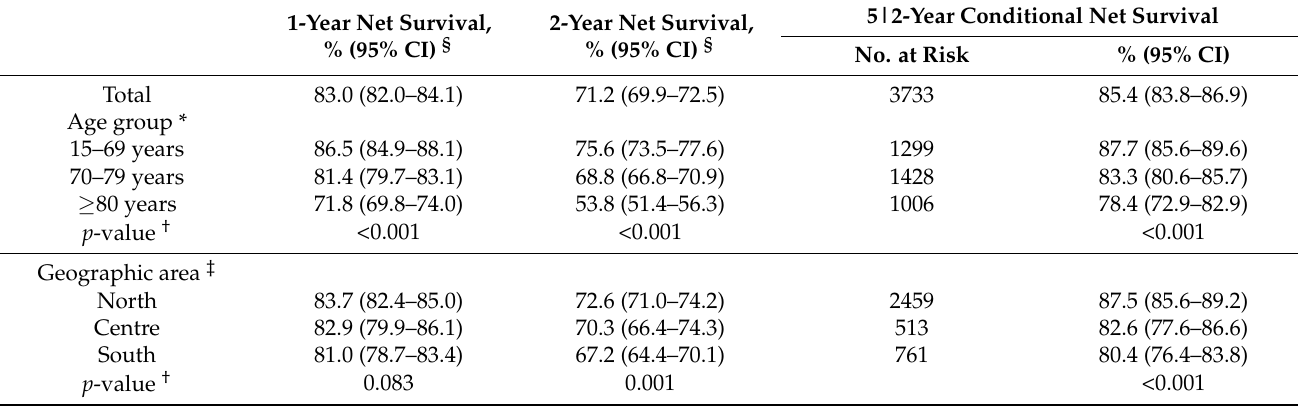
Table 2. One- and 2-year net survival and 5|2-year conditional net survival from vulvar squamous